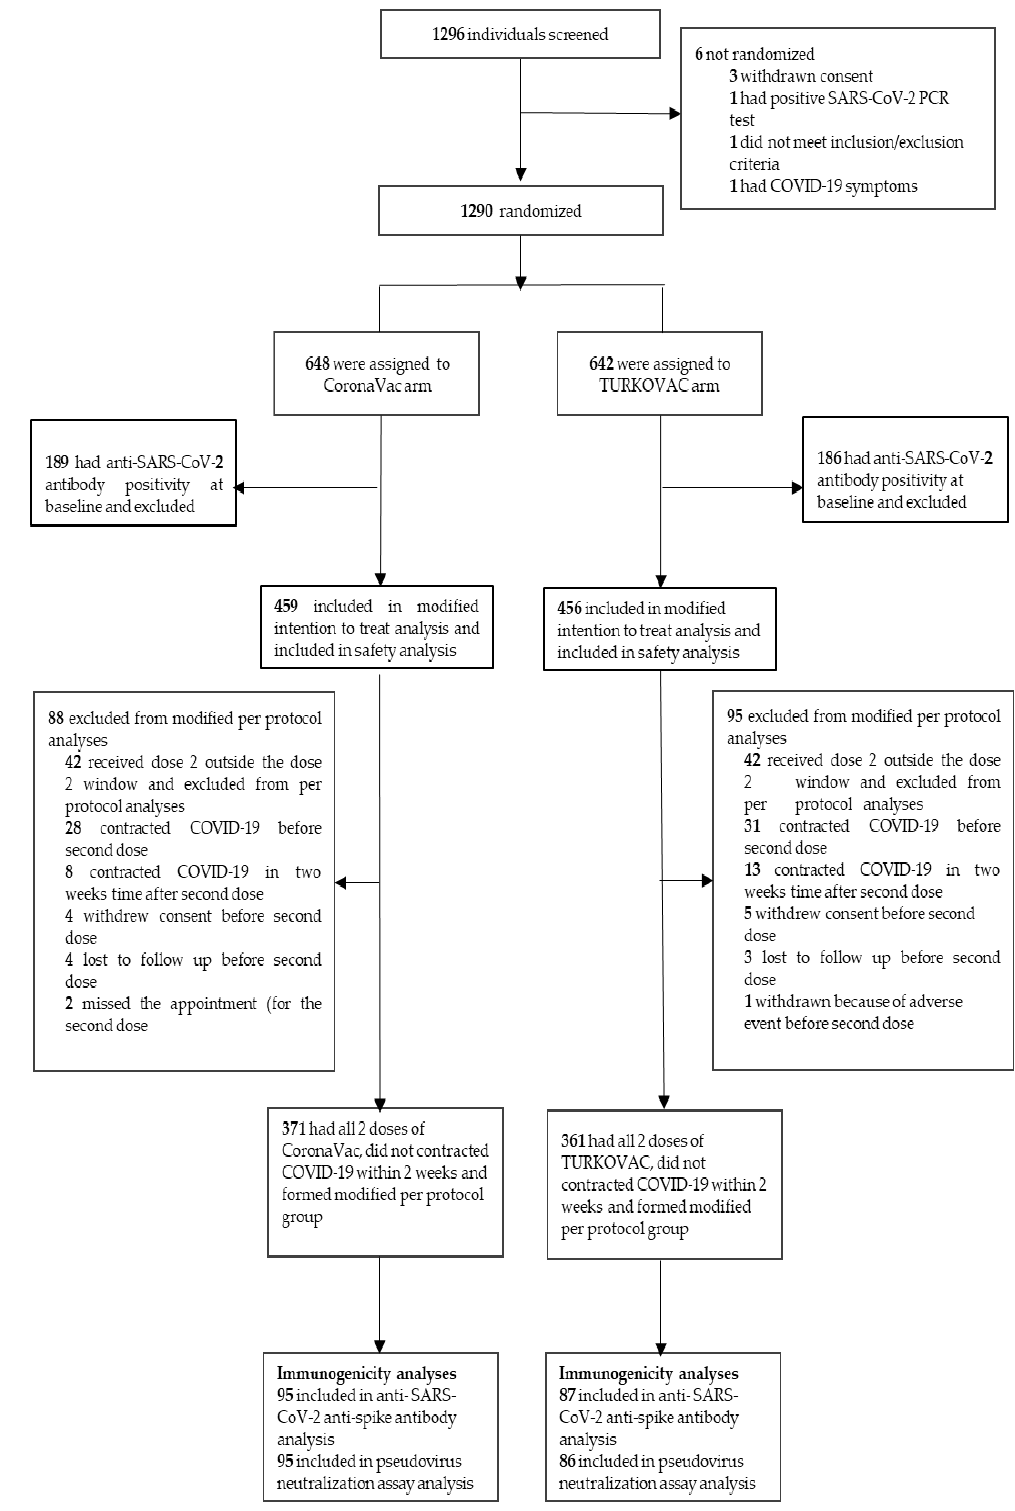
Figure 1. Study flowchart. SARS-CoV-2, severe acute respiratory syndrome coronavirus-2; PCR, polymerase chain reaction; COVID-19, Coronavirus disease 2019.